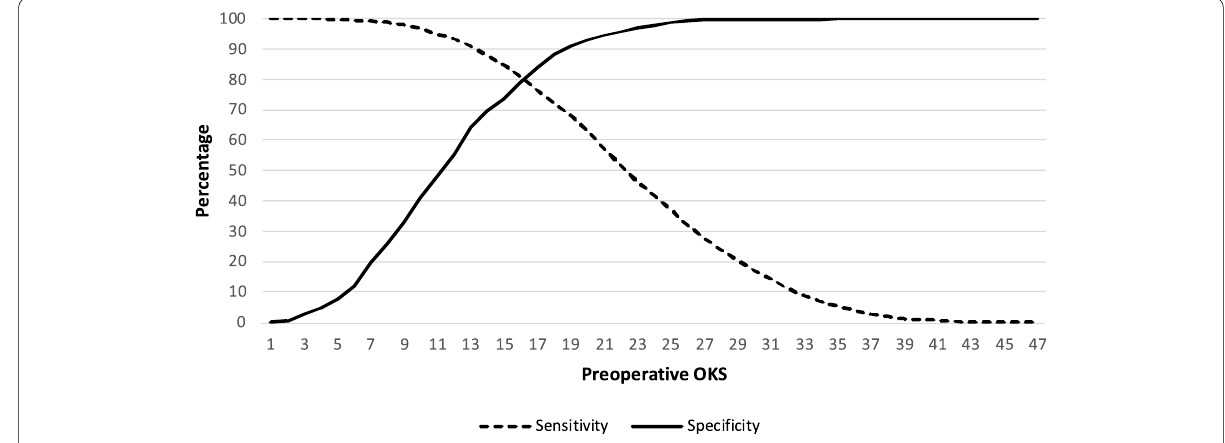
Fig. 3 Sensitivity and specificity plot for the preoperative OKS as a predictor of a health state WTD. Red line represents the threshold value on the OKS that offers the greatest sensitivity and specificity